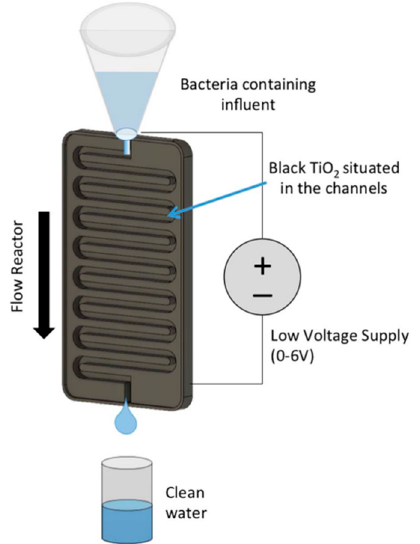
Figure 16. Schematic of a channel reactor using titanium nanotubes annealed in 2% hydrogen. (Reproduced with permission from [70]: Carlson, K.; Elliott, C.; Walker, S.; Misra, M.; Mohanty, S. An effective, point-of-usewater disinfection device using immobilized black TiO 2 nanotubes as an electrocatalyst. J. Electrochem. Soc. 2016 , 163 , H395–H401, doi:10.1149/2.0651606jes. Copyright (2016), IOP Publishing (Bristol, UK)).